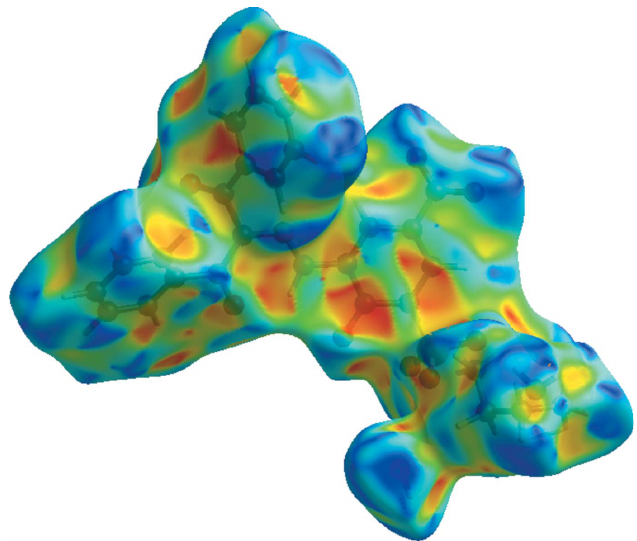
Figure 5 View of the three-dimensional Hirshfeld surface of the title complex plotted over shape